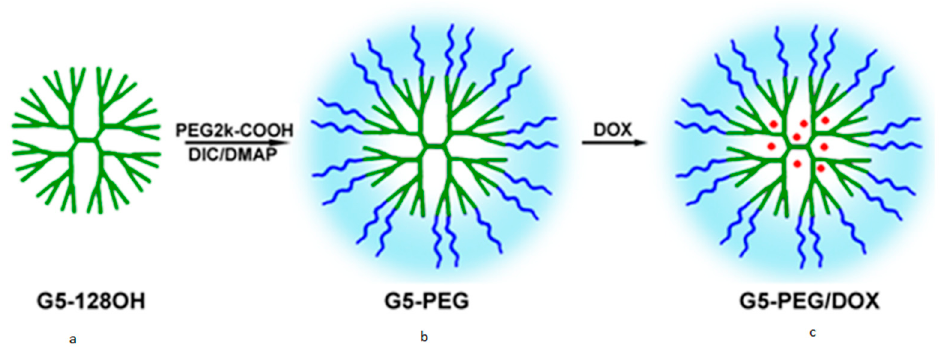
Figure 20. ( a ) Hydrophobic (G5) dendri- poly(ester)-(OH) 128 core, ( b ) [Core: dendri- poly(ester)- (OH) 128 ;(G5)]-Shell [PEGylated] structure, ( c ) [Core: dendri- poly(ester)-(OH) 128 ;(G5)]-Shell [PEGylated] structure with encapsulated doxorubicin (DOX). Reprinted with permissions from [74]. Copyright 2013 American Chemical Society.